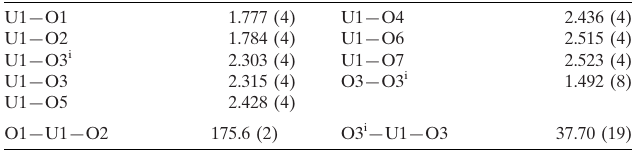
Data collection Rigaku R-AXIS RAPID diffractometer